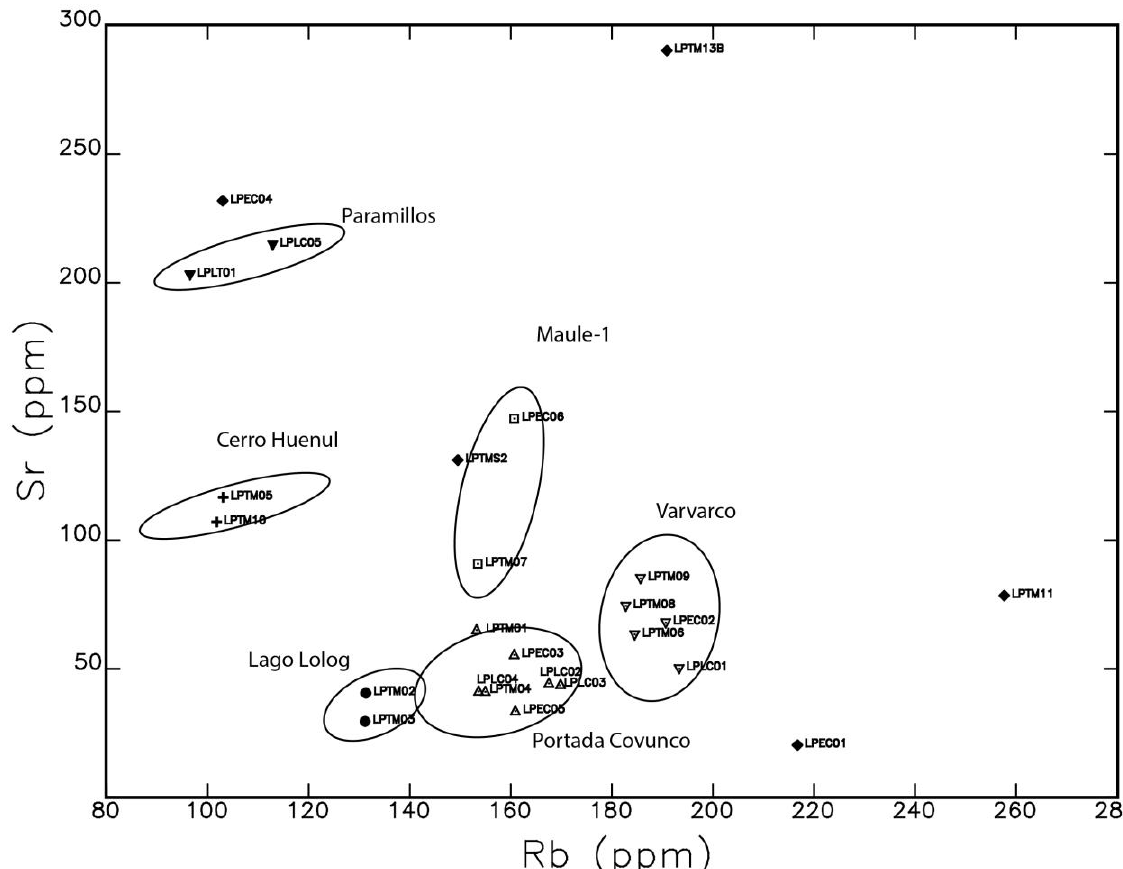
Figure 2. Artifacts and correspondence to the six known sources. Bivariate plot of Sr v. Rb (graphic by Michael D.